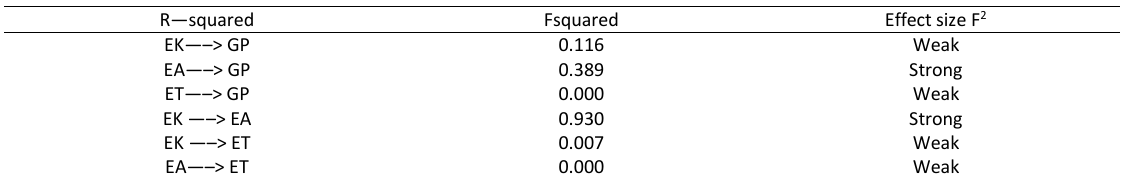
Table 7: Effect size (F 2 )